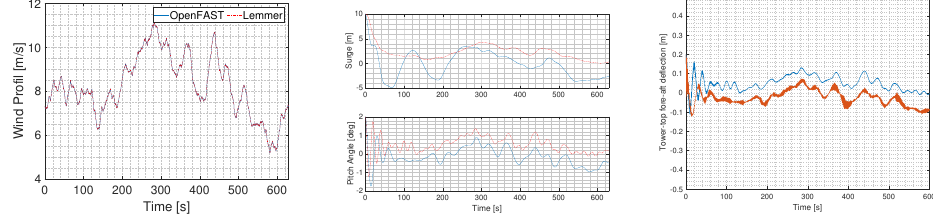
Figure 5. Simulation comparison following conditions of [8] with OpenFAST code in blue and Lemmer model in red: wind speed profile ( left ), surge and pitch translational DOFs ( middle ) and tower-top fore-aft deflection ( right ).